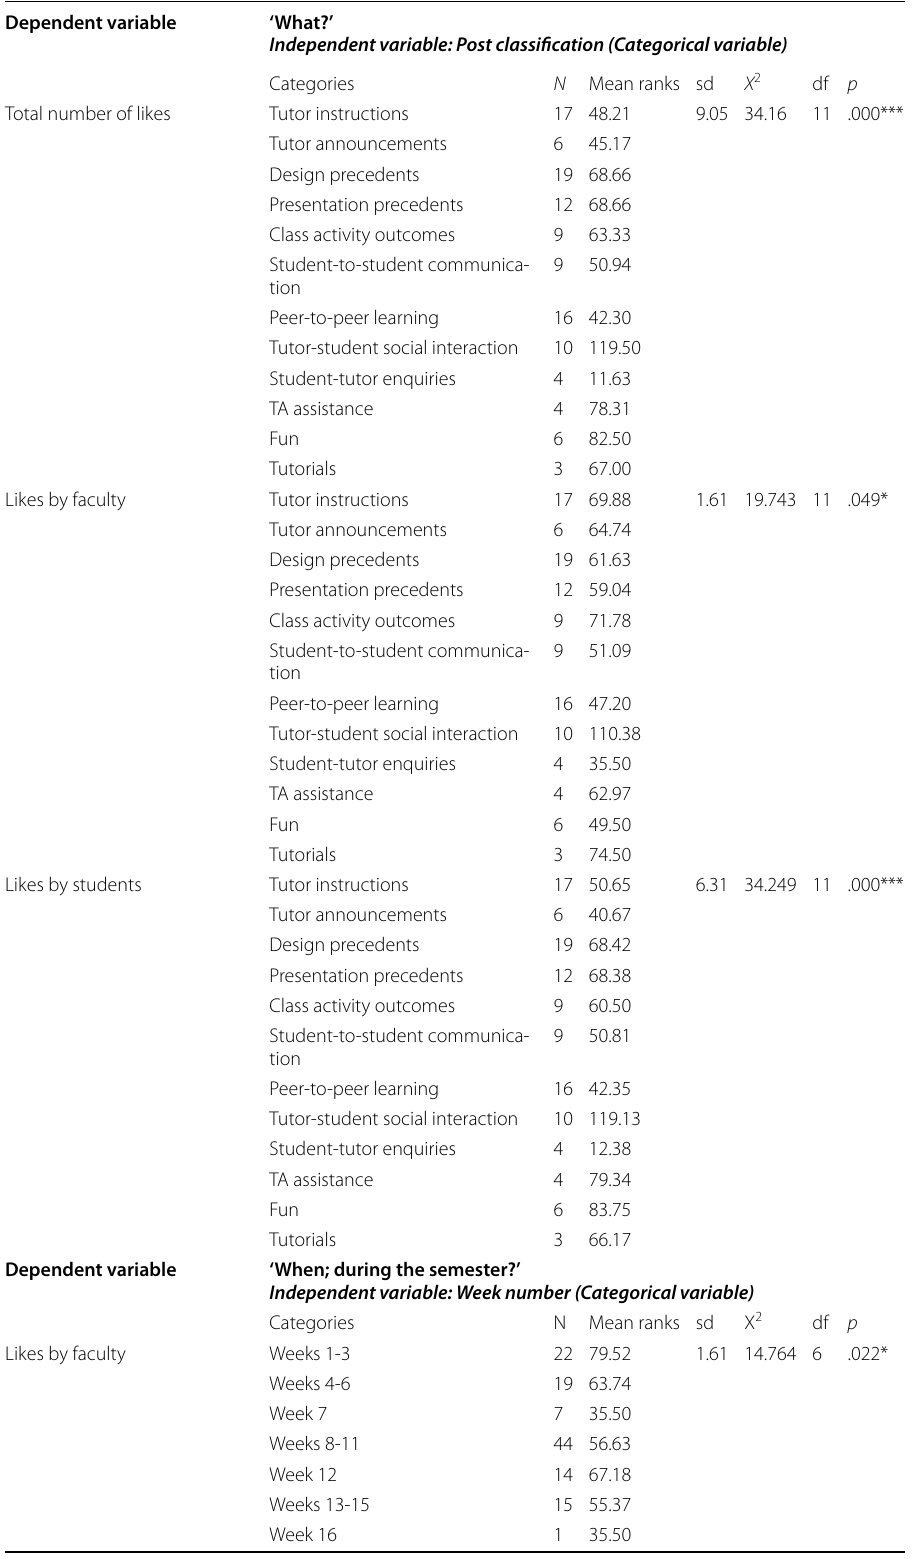
Table 2 Significant results of Kruskal-Wallis H tests. Only significant results are shown Dependent